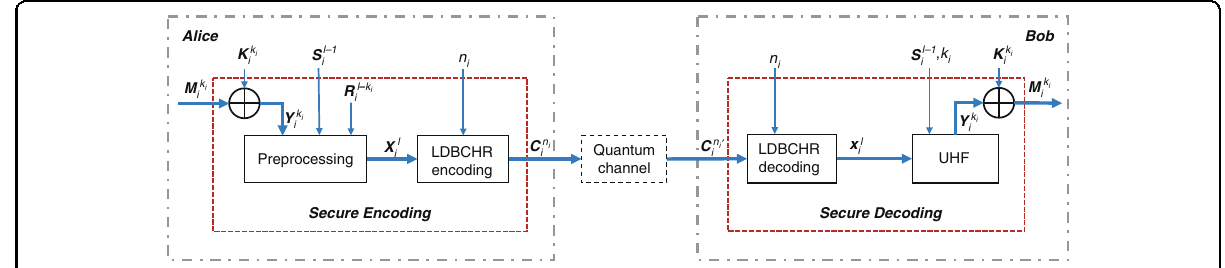
Fig. 5 Secure coding. Structure of the secure coding scheme and the data stream of the i th frame, which consists of the XOR, preprocessing, LDBCHR encoding/decoding and UHF